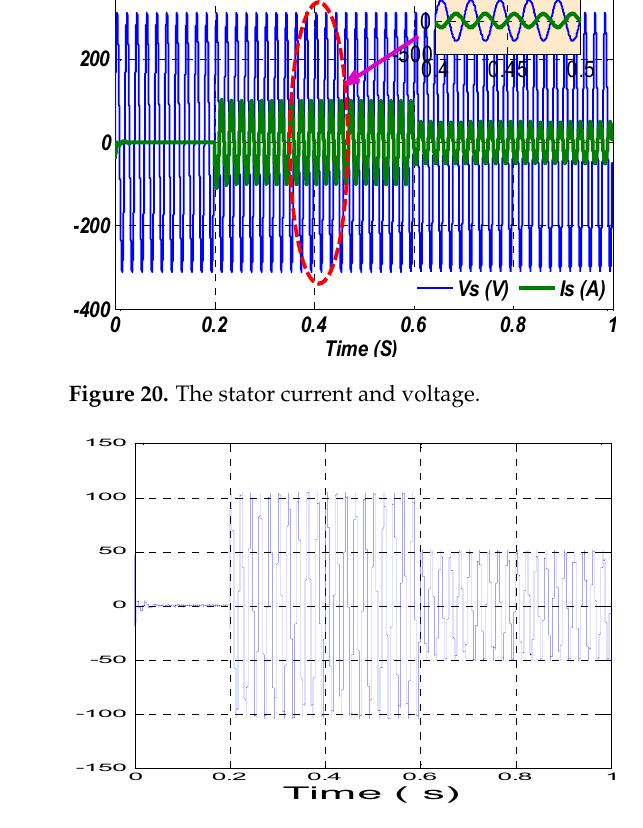
Figure 21. The stator current (A).